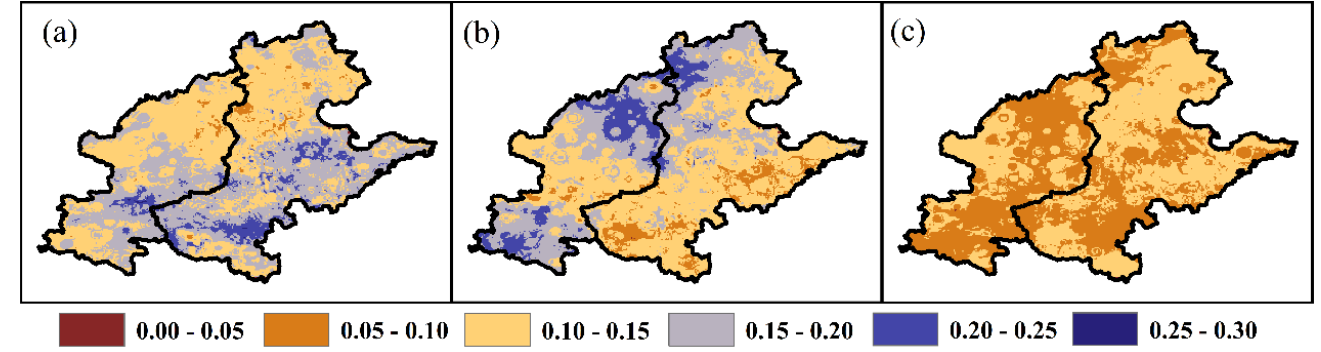
Figure 10. Frequency variation in different drought levels in the NCP ( a ) and LP ( b ) under the RCP4.5 scenario. Frequency variation in different drought levels in the NCP ( c ) and LP ( d ) under the RCP8.5 scenario.